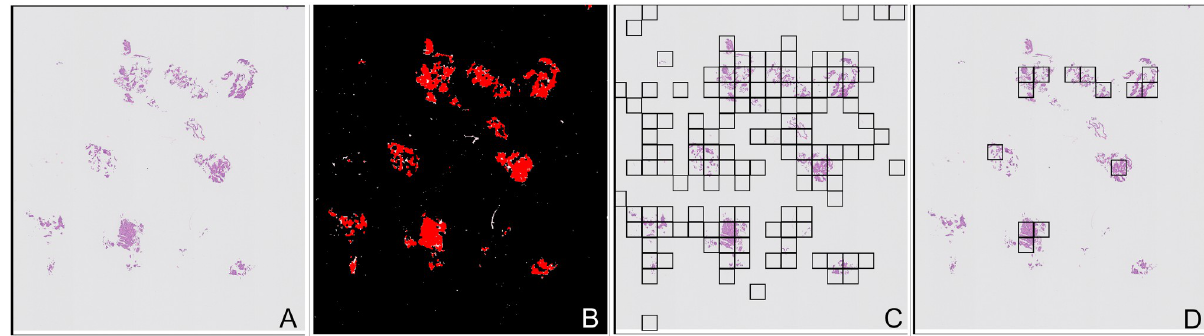
Fig 17. Example of a slide where a patching problem gives an incorrect slide classification. “Malignant” slide is classified as “insufficient”. Black squares shown in Fig 17c, 17d are patches of 1024 × 1024 pixels. (A) Thumbnail showing slide with patching problems. (B) Mask showing tissue detection prior to patching. (C) Tissue patches created when any tissue in a patch creates a patch. (D) Actual tissue patches created as patch has to be more tissue than background, here 10 patches are